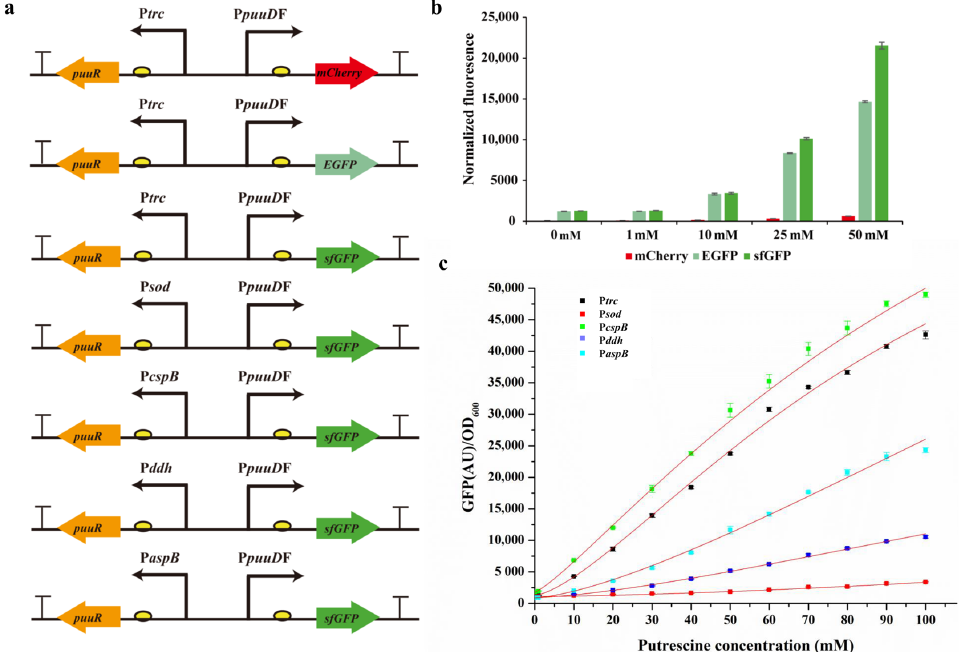
Figure 4. Optimization and characterization of the genetic components of pSenPuuR. ( a ) Constructed plasmid family to optimize the genetic components of pSenPuuR; ( b ) optimization of reporter proteins in pSenPuuR; ( c ) optimization of PuuR expression levels in pSenPuuRsfGFP. Fluorescence data of different expression levels of PuuR-based biosensors for putrescine concentrations ranging from 0 to 100 mM were fitted to the Hill equation. Values are presented the mean ± standard deviation of three independent experiments.